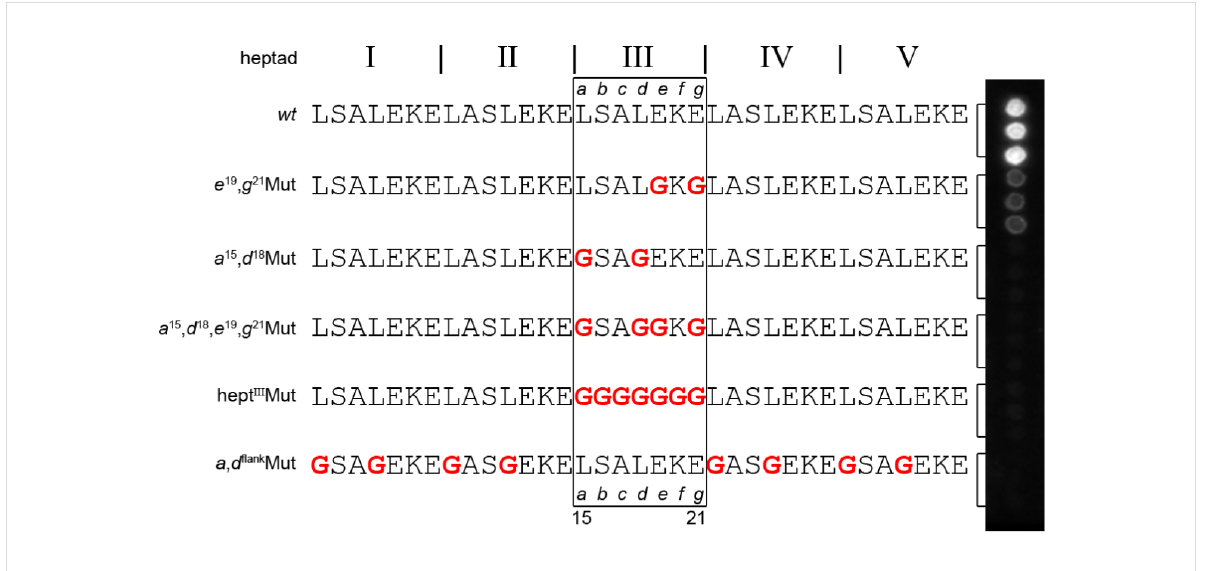
well as a series of hydrophobic side chains were considered at the e 19 and g 21 positions. Interactions between the chimera and immobilized α -mutants were measured by using a peptide array